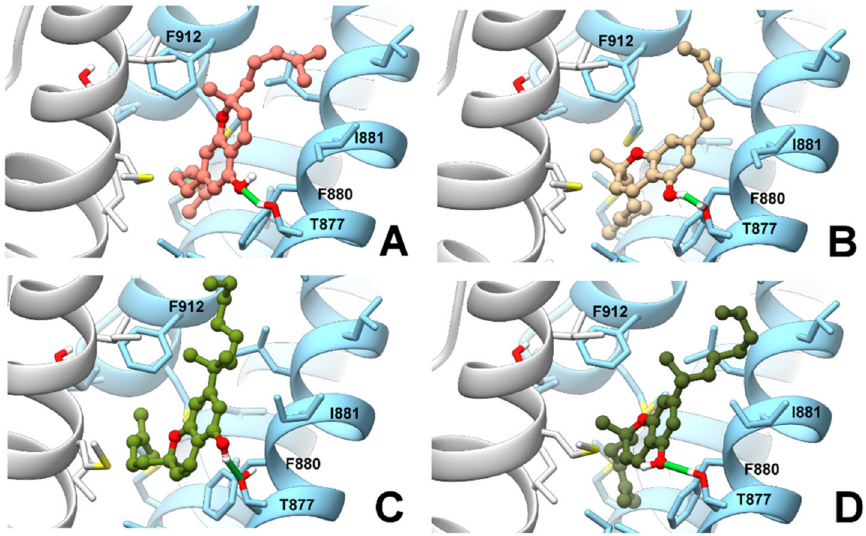
Figure 3. Representative complexes of the rTRPA1 model with (R)-CBC (colored in salmon, panel ( A )), (S)-CBC (colored in tan, panel ( B )), (R)-CBC-DMH (colored olive drab, panel ( C )) and (S)-CBC-DMH (colored in dark green, panel ( D )). A ribbon representation is used for the protein backbone and sticks for protein side chains of residues within 5 Å from the ligand, in ball & stick representation. H-bonds are shown as green sticks. Carbon atoms are painted according to receptor subunits. Sulfur, oxygen, and polar hydrogen atoms are painted yellow, red, and white,